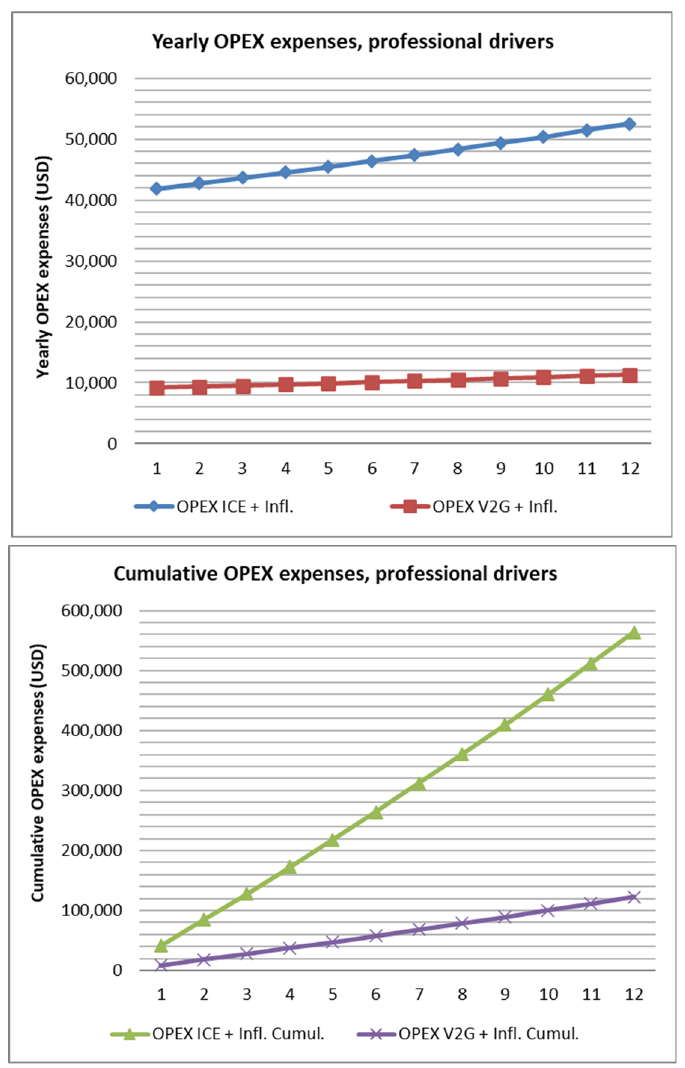
Figure 3. Yearly and cumulative OPEX expenses between an ICE vehicle and a V2G, professional drivers.